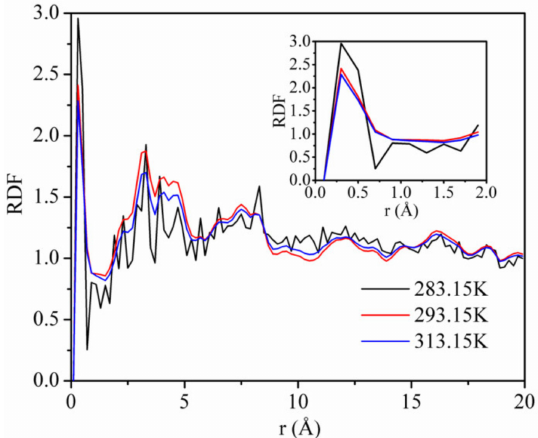
Figure 11. Radial distribution functions (RDFs) of CO 2 on kaolinite at a pressure of 5 MPa and the di ff erent